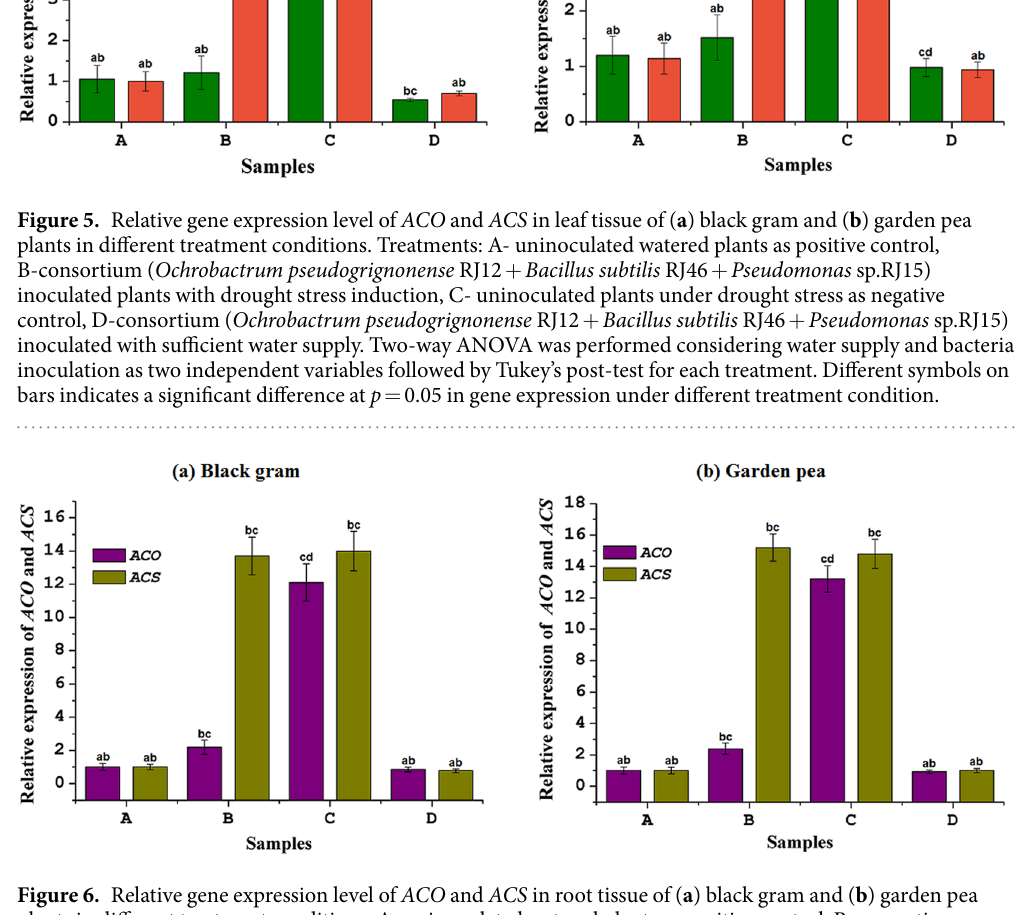
bacterial consortium is capable of regulating stress ethylene levels, thereby conferring drought stress tolerance in the tested host plants. Microorganisms with multi-faceted mechanisms of action are beneficial for plant growth promotion during abiotic stress condition 49 . Therefore, different inherent PGP attributes were also screened and quantified in the selected ACC deaminase positive bacterial strains. The bacterial strains were potent for many PGP traits, such as IAA production, siderophore production, HCN production, phosphate solubilisation, and nitrogen fixation even under high osmotic stress conditions. According to Glick et al . (2007), bacterial PGP traits have a positive influence on plant growth and development by increasing nutrient availability during stressful conditions 50 . It is well-known that IAA stimulates the transcription of the plant enzyme ACC synthase 51 , which catalyzes the for- mation of ACC. In this case, IAA induces ethylene production in the plant. However, increases in ethylene levels have feedback inhibitory effects on IAA signal transduction, which thereby limits the activity of ACC synthase 51 . Thus, the association of IAA-producing bacteria in plants will ultimately trigger the production of relatively high concentrations of ACC and, subsequently, the feedback inhibition of IAA synthesis. However, PGPB with both IAA- and ACC-deaminase-producing activity will control the excess ethylene production level and thereby lessen